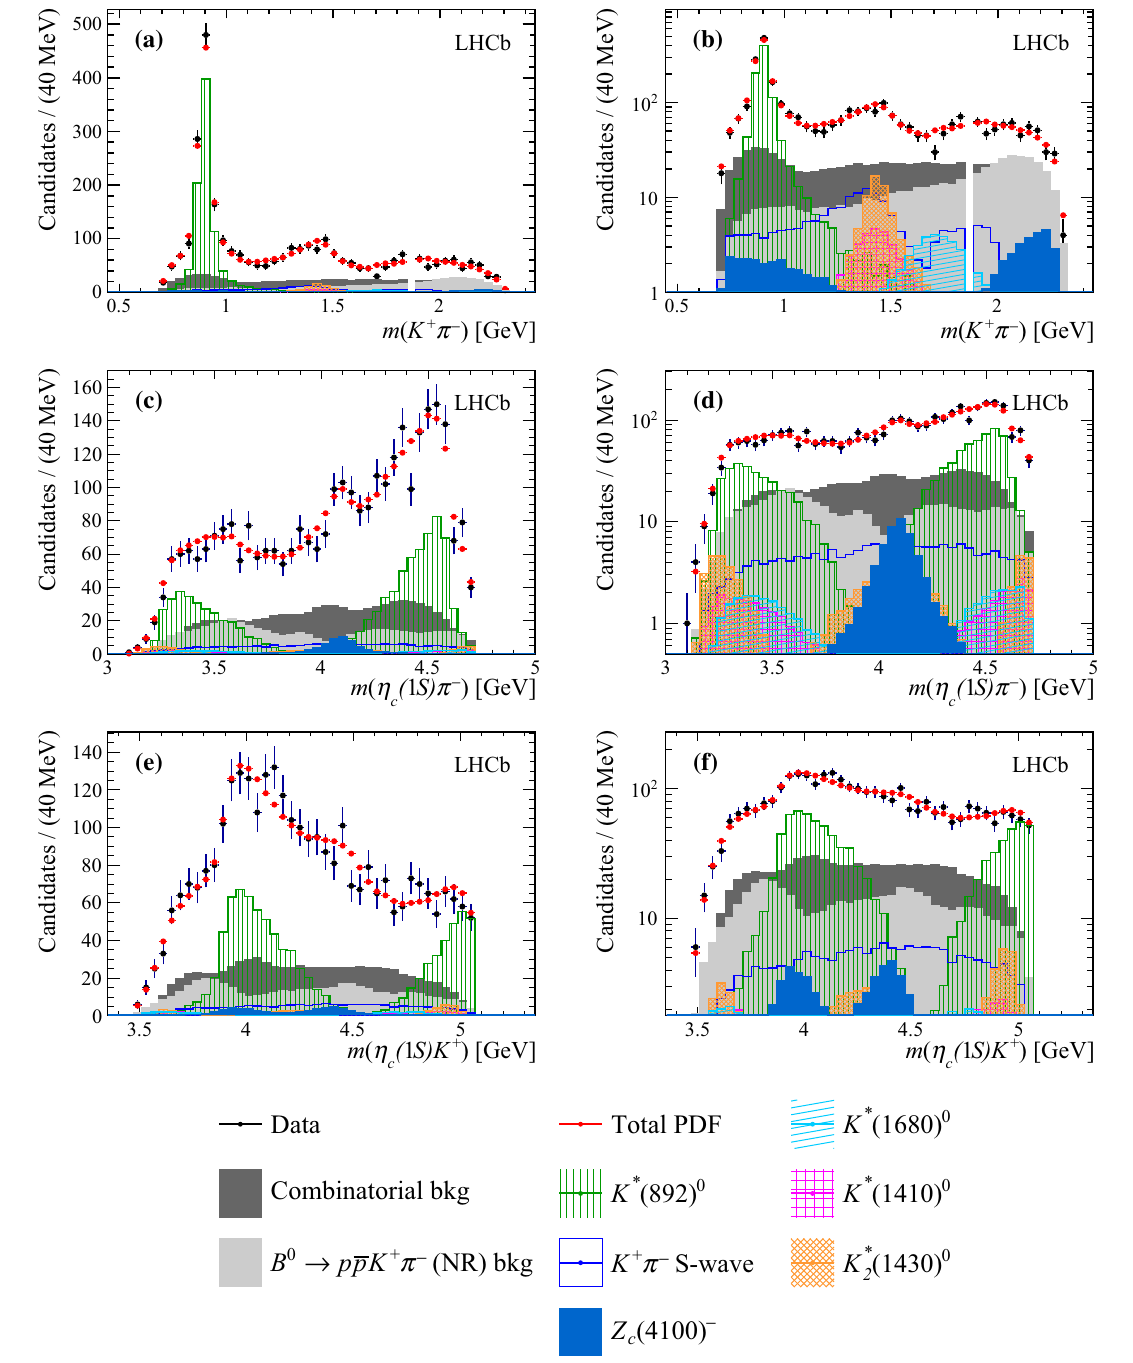
Fig. 9 Projections of the data and amplitude fit using the nominal model onto a m ( K + π − ) , c m (η c π − ) and e m (η c K + ) , with the same projections shown in b , d and f with a logarithmic vertical-axis scale.